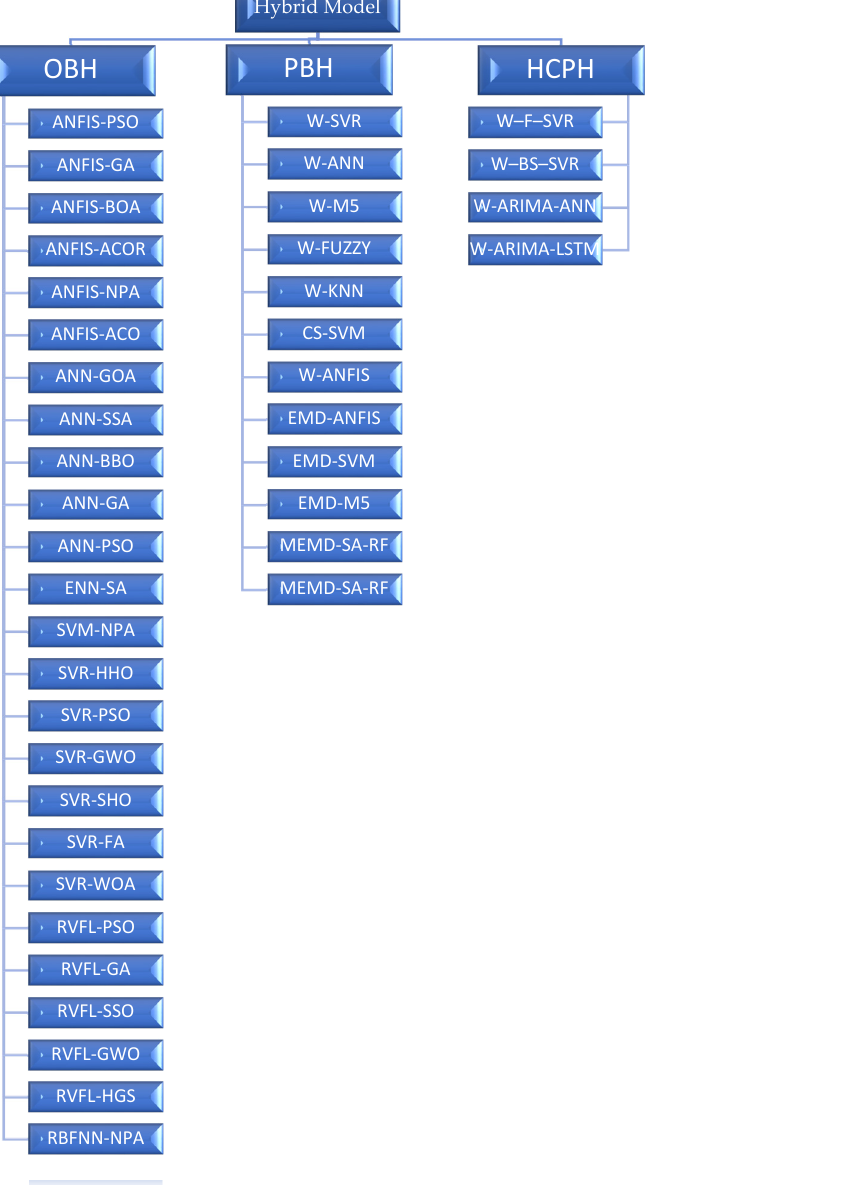
Figure 3. Classification of hybrid models that were employed for forecasting drought indices.